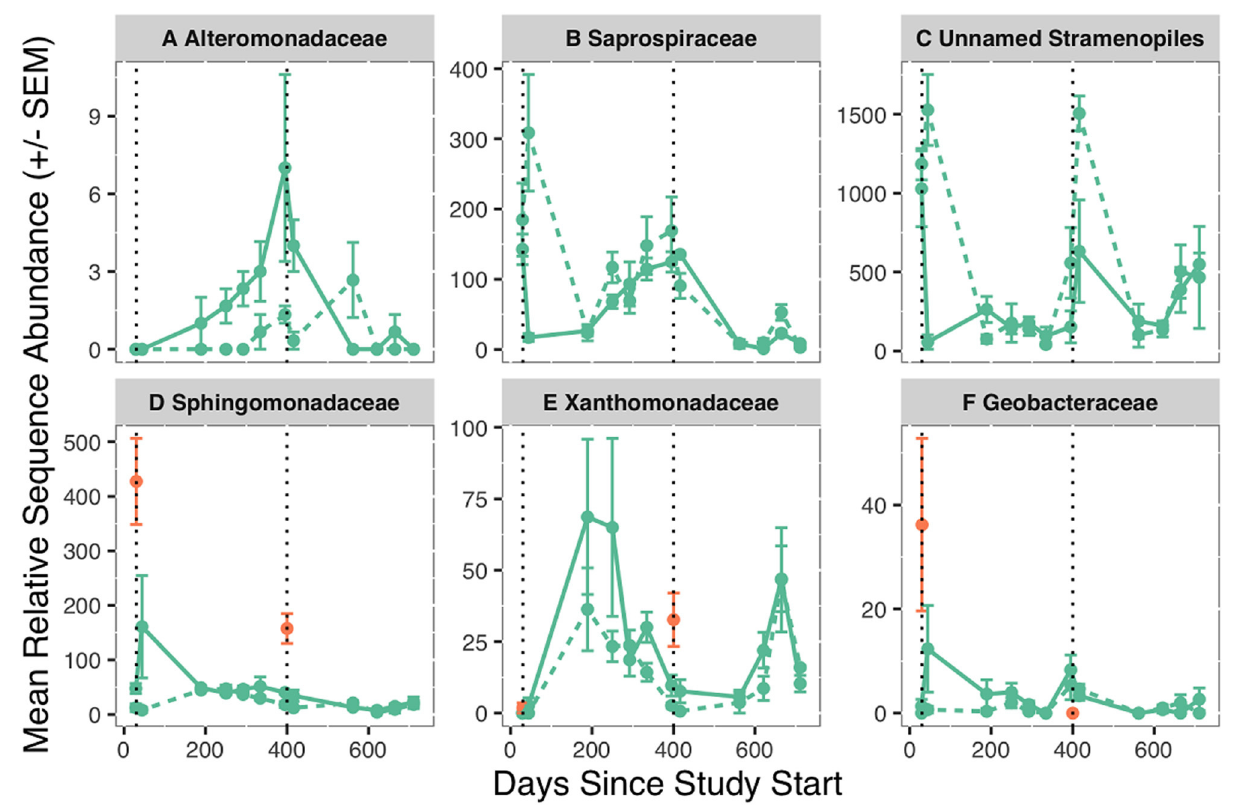
FIGURE 2 | Mean relative sequence abundance ( ± SEM) of Alteromonadaceae (A) , Saprospiraceae (B) , Unnamed Stramenopiles family (C) , Sphingomonadaceae (D) , Xanthomonadaceae (E) , and Geobacteraceae (F) in biofilms (green) over time. Sphingomonadaceae , Xanthomonadaceae , and Geobacteraceae that were part of the carrion associated communities are shown in orange, as these families were also indicator taxa for year of salmon carrion addition within the salmon carrion microbial communities. The dashed line is the control reach, and the solid line is the salmon reach. Black, dotted vertical lines represent the day of salmon introduction. Relative sequence abundance is the number of reads in the rarefied (2,500 reads)